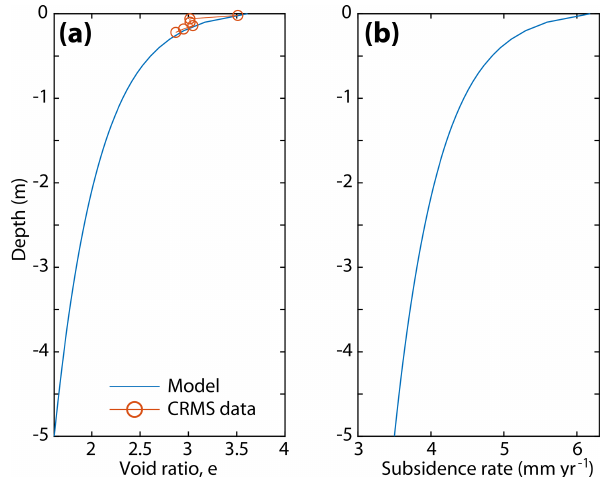
Figure 2. Equilibrium depth dependence of the (a) void ratio, as- suming sediment deposition with a void ratio of 3.5, and (b) subsi- dence rate (SS + DS), assuming mass-balance and a DS (deep sub- sidence) rate of 3mmyr − 1 at a depth of 10m. CRMS data show the average void ratio across all CRMS